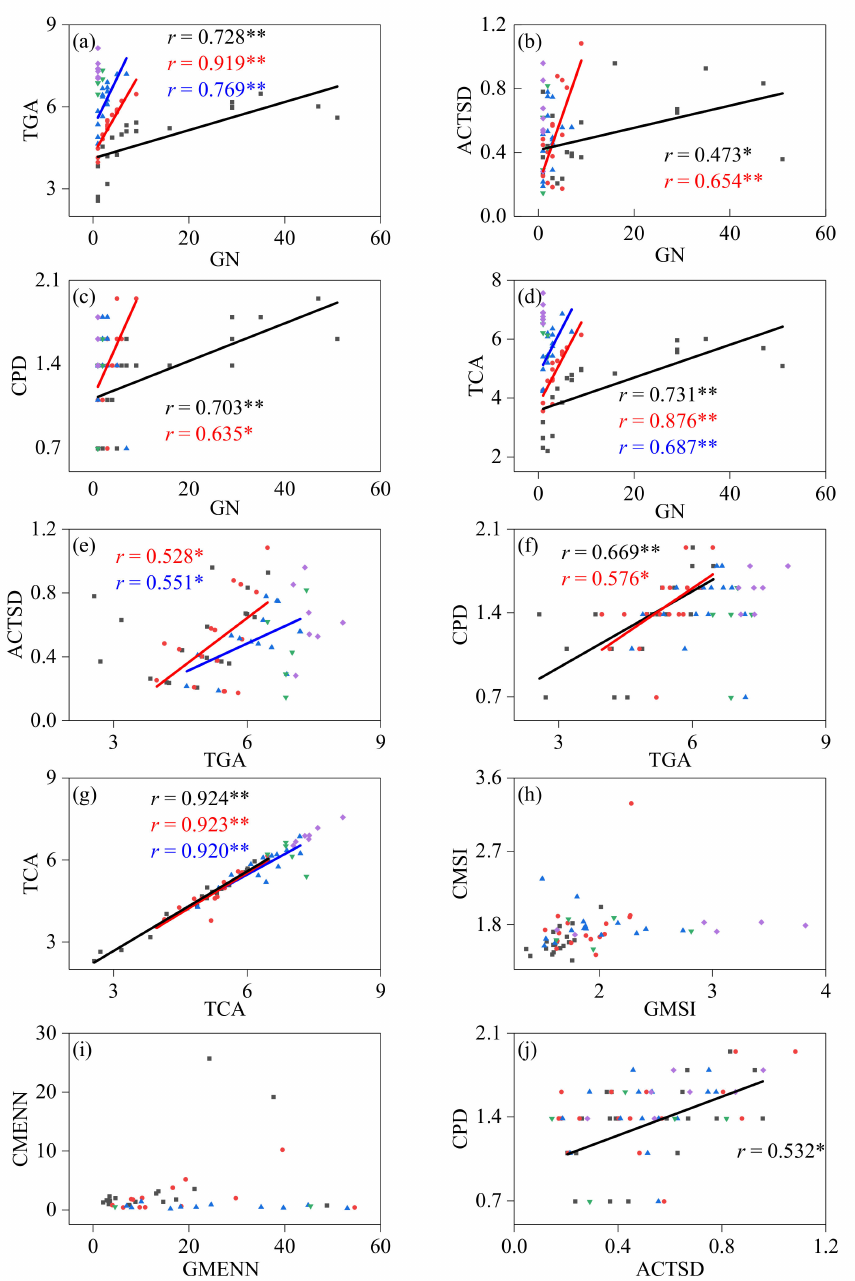
Figure 5. Relationship between GN with ( a ) TGA, ( b ) ACTSD, ( c ) CPD, and ( d ) TCA; relationship between TGA with ( e ) ACTSD, ( f ) CPD, ( g ) TCA, ( h ) GMSI and CMSI, ( i ) GMENN and CMENN, and ( j ) ACTSD and CPD in different gap groups. ACTSD–autumn color-leaved tree species diversity; CMENN–mean Euclidean nearest-neighbor distance of color-leaved patches; CMSI–mean shape index of color-leaved patch; CPD–color-leaved patch diversity; GMENN–mean Euclidean nearest- neighbor distance of gaps; GMSI–mean shape index of gaps; GN: number of gaps; TCA–total color-leaved patch area; TGA–total gap area. Black solid square indicates the value in small gap group; red solid circle indicates the value in medium gap group; blue solid triangle indicates the value in large gap group; green solid triangle indicates the value in very large gap group; purple solid diamond indicates the value in extreme large gap group. Solid lines with different colors indicate that there is a significant relationship between gap characteristics with ACTSD and color-leaved patch structure attributes in different gap groups; if there is no significant relationship, it is not marked in the figure; * and ** indicate p < 0.05 and p < 0.01,